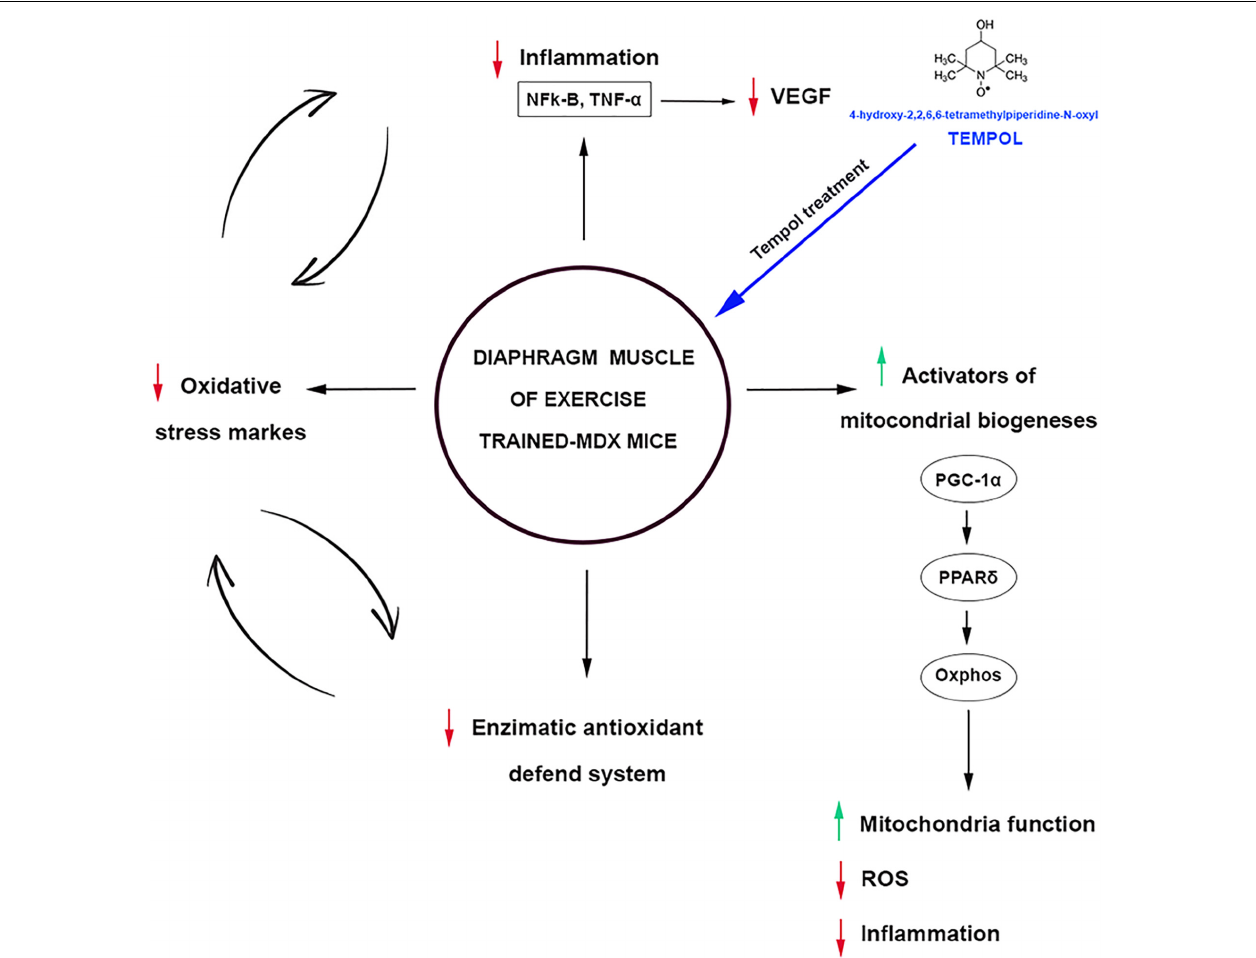
FIGURE 10 | Oxidative stress, inflammation, and activators of mitochondrial biogenesis: targets of Tempol treatment in the diaphragm muscle of exercised trained- mdx ↑ mice. ↓ Tempol down-regulated; vicious